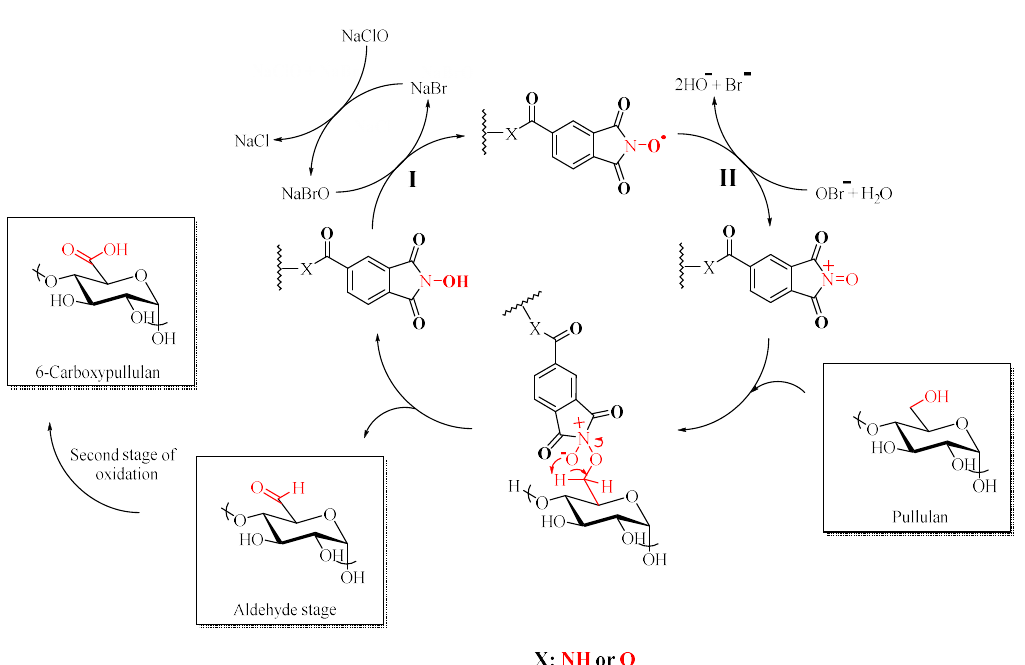
Figure 3. Proposed reaction mechanism for the pullulan oxidation in the presence of NHPI-supported catalysts/NaClO/NaBr. Table 2. Electrokinetic charge (EC) and zeta potential ( ) for pullulan samples oxidized in the presence of the NHPI-supported catalysts.